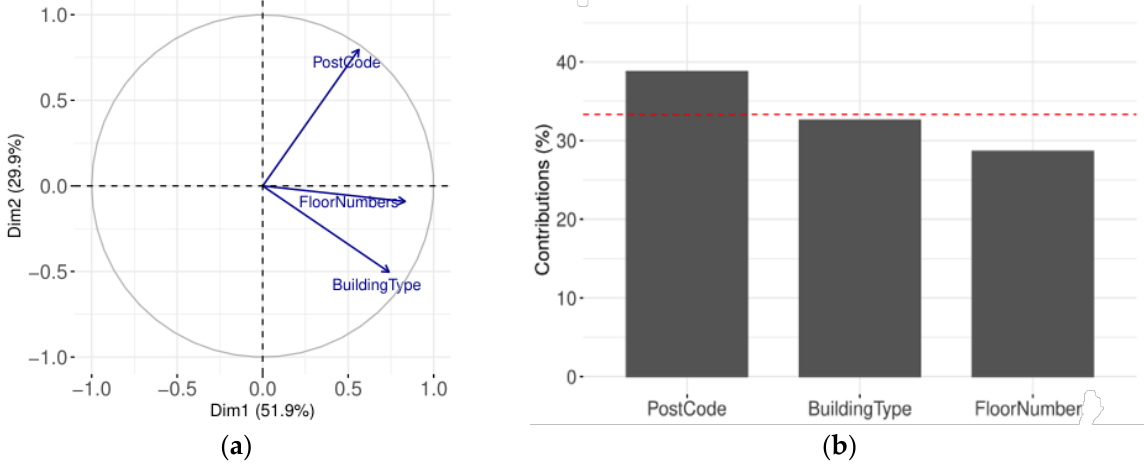
( b ) Figure 8. Factor maps of the first analysis with differentiated individuals according to ( a ) floor cov- ering (1 = Majolica, 2 = Wood, 3 = Linoleum, 4 = Carpet, 5 = Granite, 6 = Marble, 7 = Other) and ( b ) wall materials (1 = Cement, 2 = Bricks, 3 = Stones, 4 = Tuff, 5 = Other). Floors covered with tiles are all positioned in the third quadrant, and are negatively correlated with both dimensions. This indicates that the indoor radon value is the result of other factors. Finally, dwellings paved with marble occupy a position that is positively correlated with wall size and negatively correlated with floor size: these dwellings are more influenced by the material and the wall coverings in terms of indoor radioactivity. Figure 8b shows that dwellings with tuff walls are positively correlated with the wall dimension in contrast to those with concrete walls; dwellings with walls made of bricks